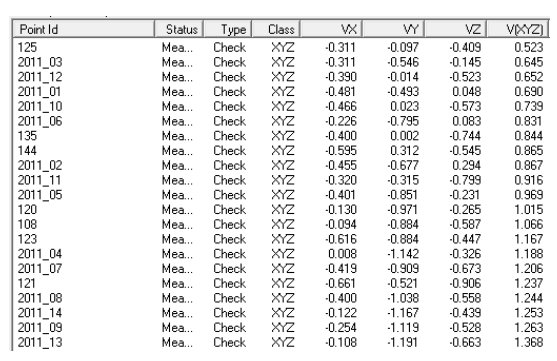
Table 9. Refine POSEO with Check Points